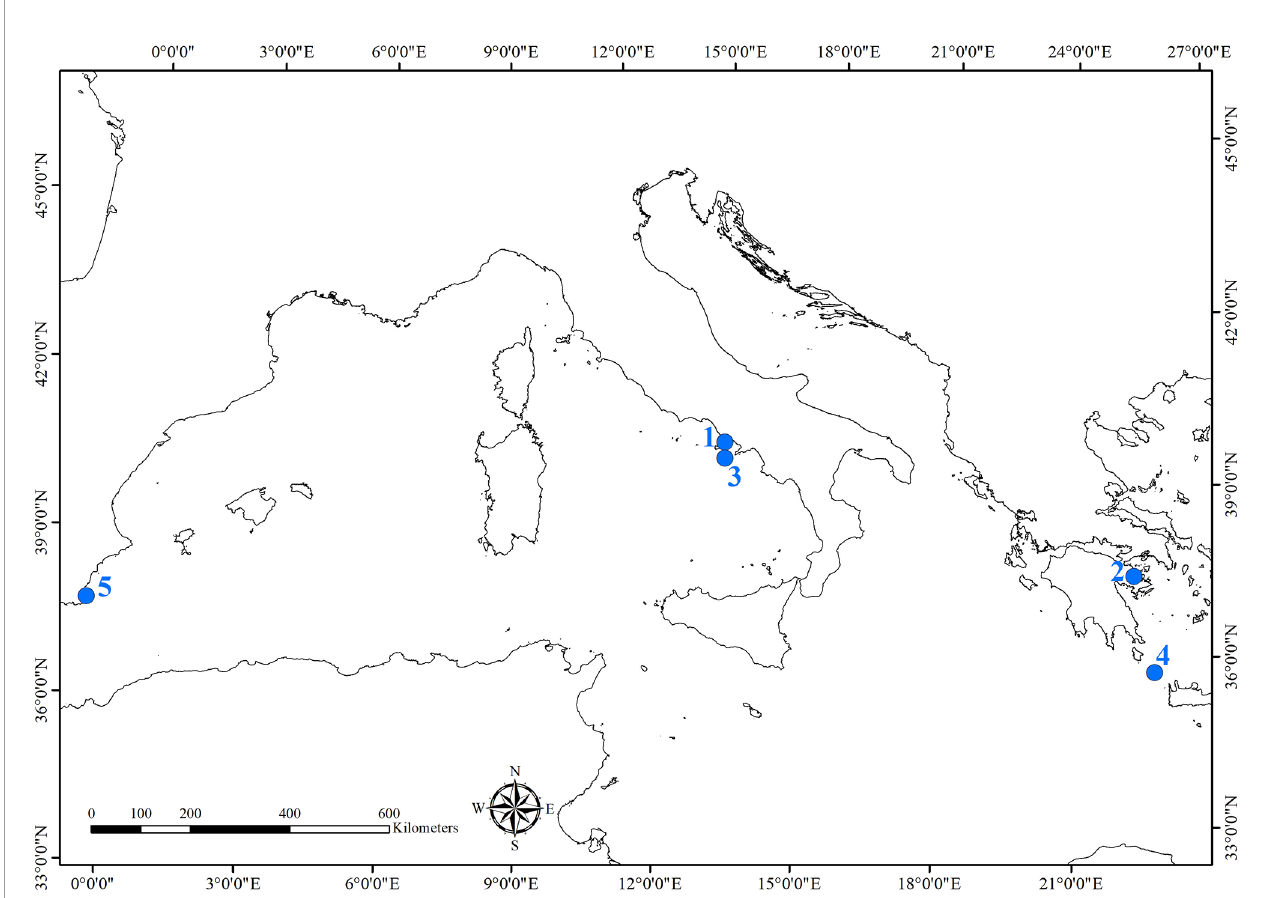
FIGURE 1 | Map of the archeological sites where studies of the bioerosion on cultural heritage were carried out. Sites were numbered as they are cited in the text: 1) Underwater Archaeological Park of Baiae; 2) Underwater archeological site of Epidaurus; 3) Grotta Azzurra, Capri; 4) Antikythera shipwreck; 5) Bajo de la Campana